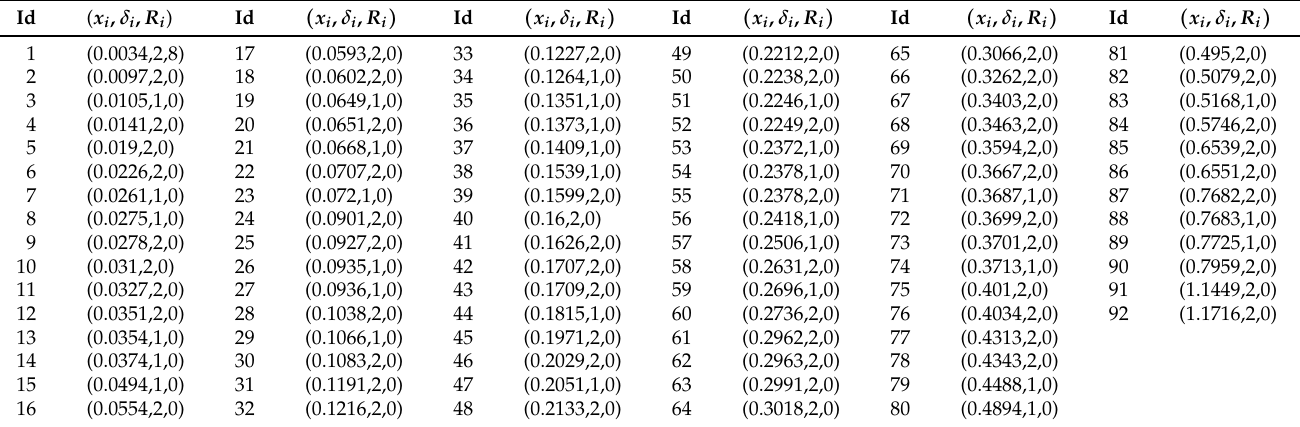
Table 13. Simulated competing risks dataset.